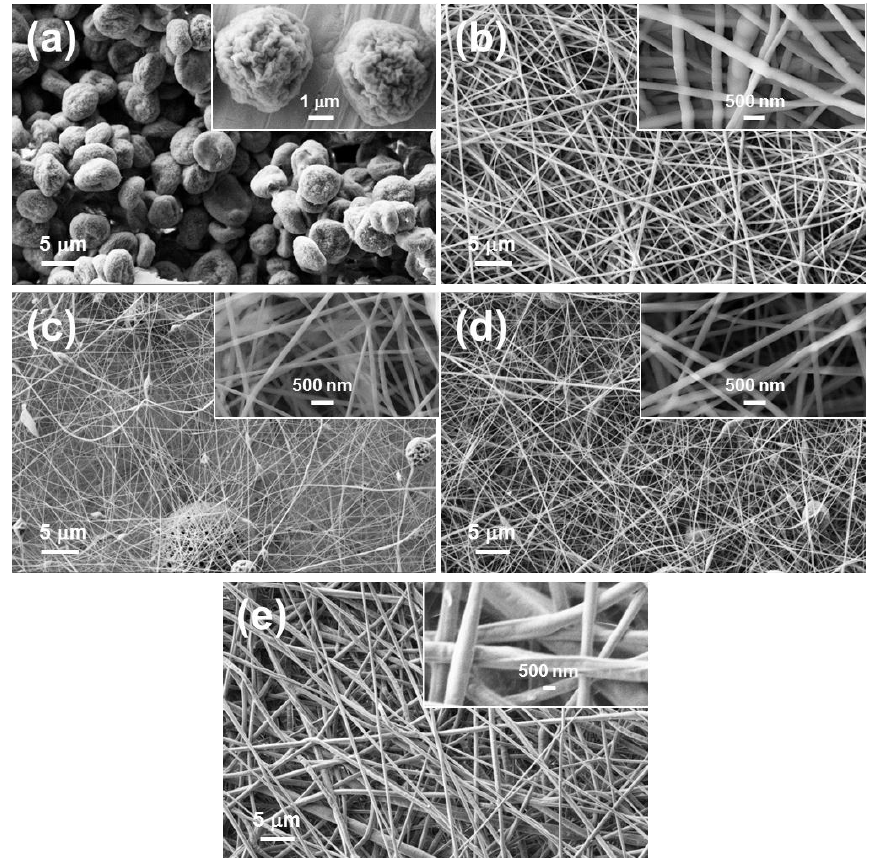
Figure 1. High and low magnification SEM micrographs of ( a ) PE44/GA-L electrosprayed microspheres (experimental conditions defined in reference 19); ( b ) unloaded PE44; ( c ) PE44/GA-S1; ( d ) PE44/GA-S2 and ( e ) PE44/GA-L electrospun fibers.